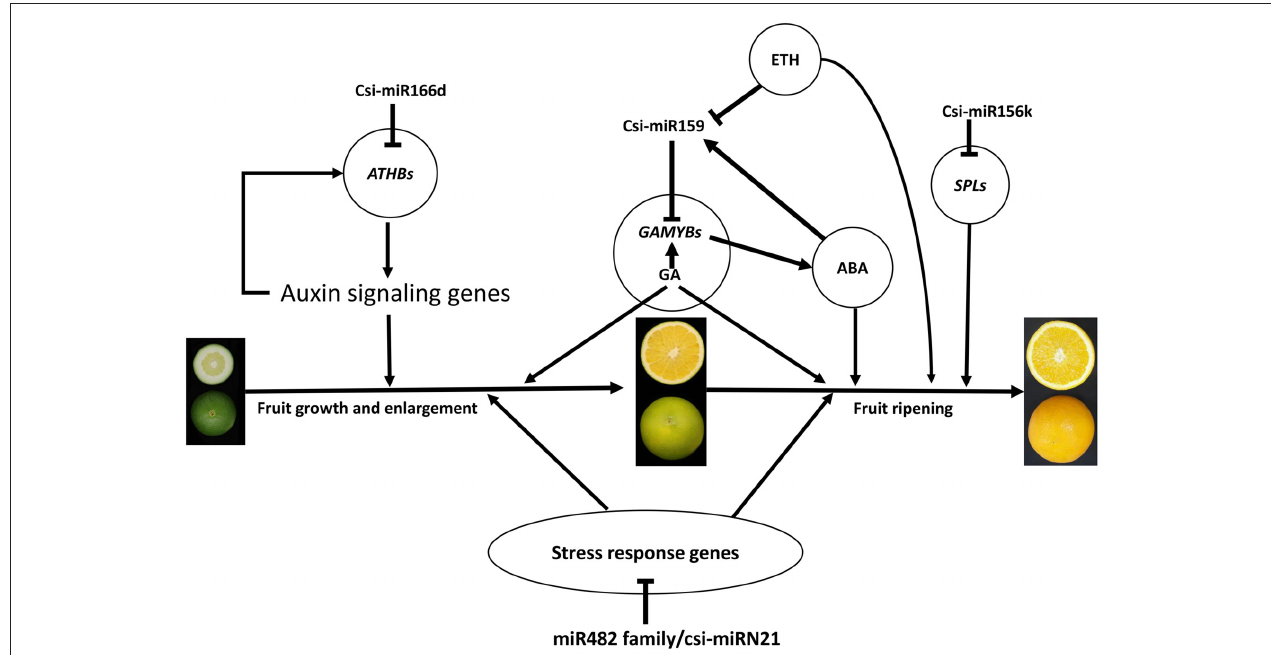
FIGURE 7 | A schematic model with the proposed roles of miRNAs involved in citrus fruit development and ripening. ABA, abscisic acid; GA, gibberellic acid; ETH,